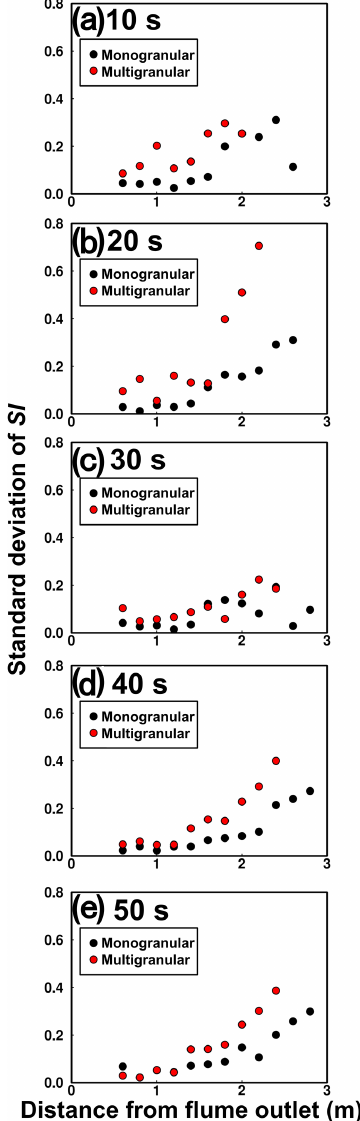
Figure 18. Standard deviation of symmetric index (SI) values: (a) after 10s from the start of flow runout, (b) after 20s from the start of flow runout, (c) after 30s from the start of flow runout, (d) after 40s from the start of flow runout, and (e) after 50s from the start of flow